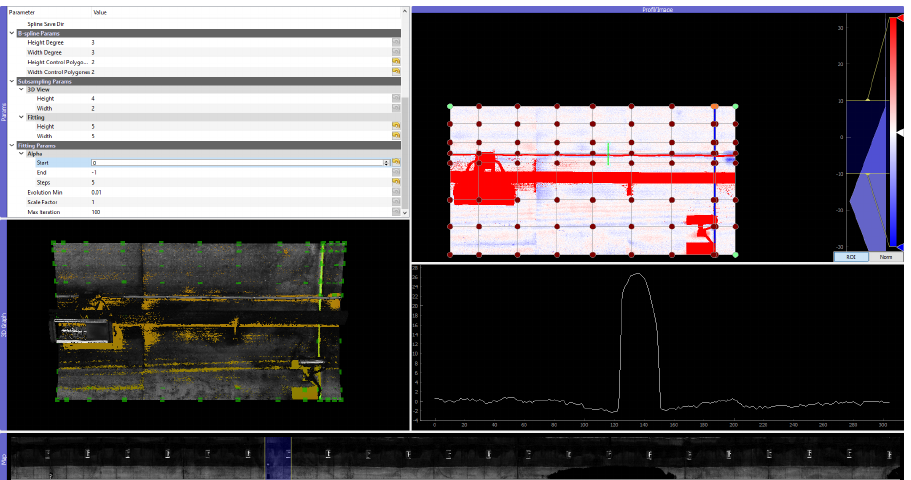
Figure 4. Screenshot of the interface for robust fitting (better visualized by zooming on the electronic version of the figure) cable with a diameter of about 25 mm can be seen. In an ex- ample shown in (Tual et al., 2021), a plate with a thickness of about 5 mm was distinguishable.